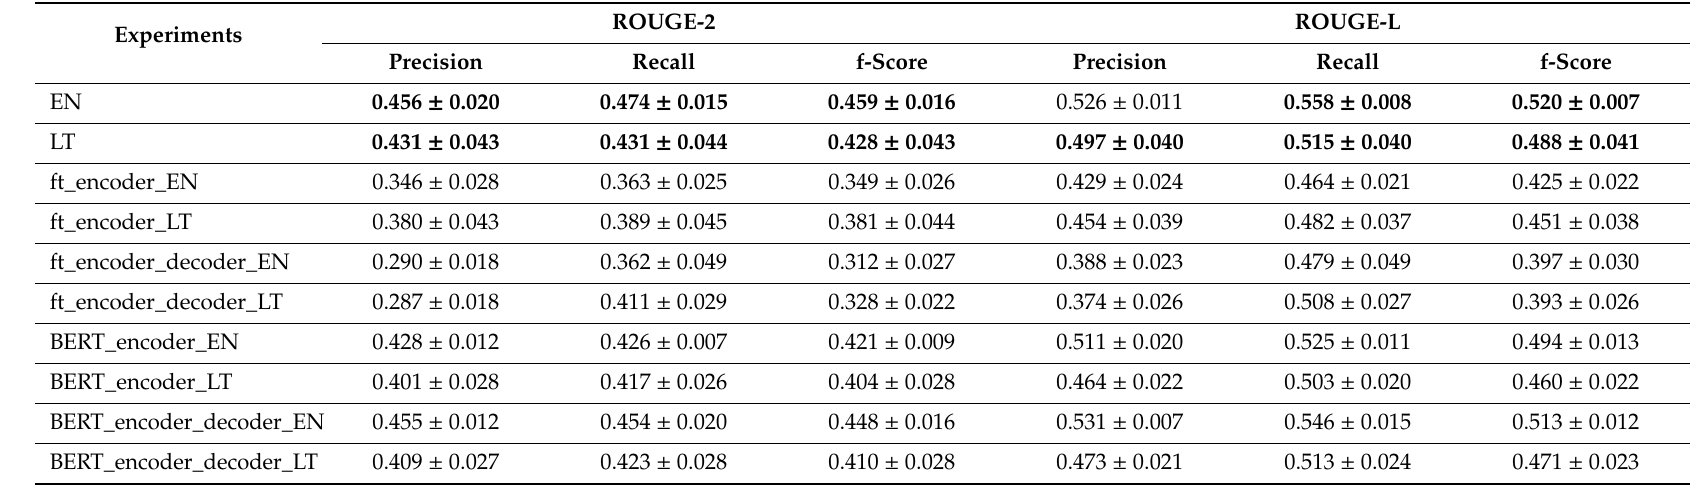
Table 3. Averaged ROUGE-2 and ROUGE-L precision / recall / f-score values with confidence intervals using the LSTM encoder and decoder model with di ff erent vectorization types on the dataset with separated punctuation. The best values in the column for EN and LT are in